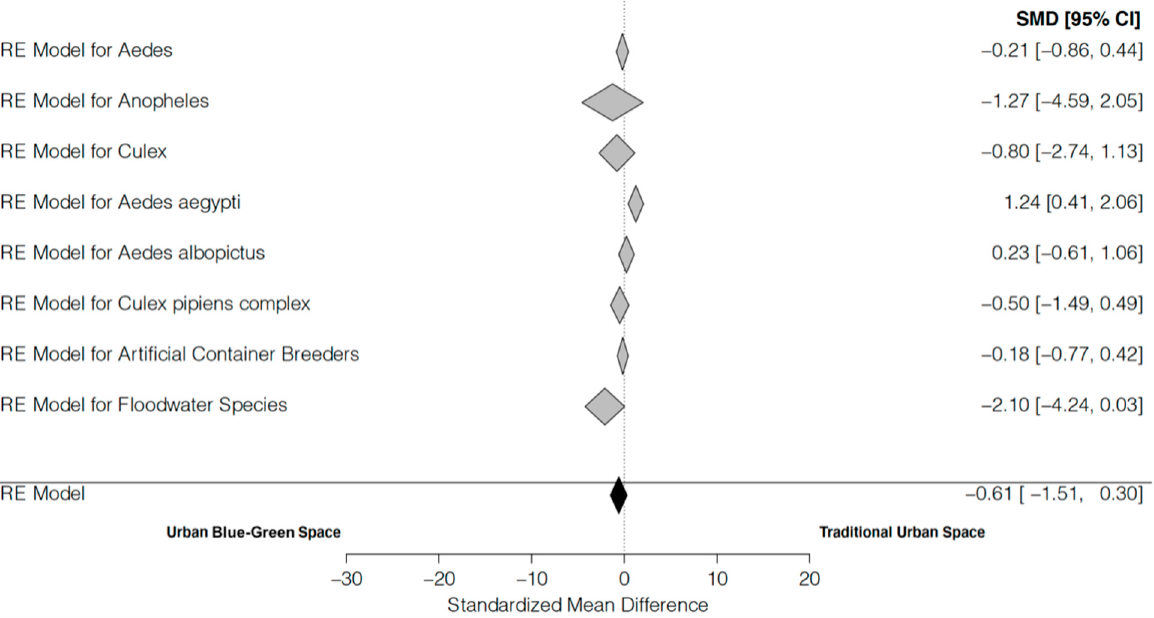
Figure 3. Mean effect size of blue-green space on mosquito abundance compared to traditional urban areas across multiple genera, species, and larval habitat guilds. SMD refers to the standard mean difference in abundance and the 95% confidence interval is reported in brackets.